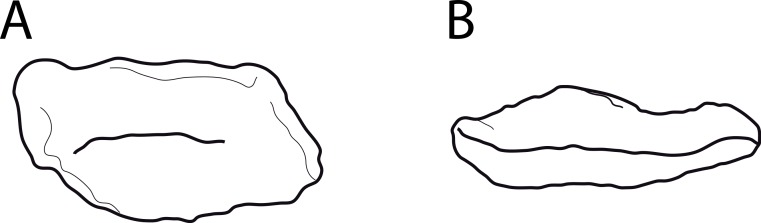
Diplodocid carpals.Carpal elements of Galeamopus sp. SMA 0011 (A) and Brontosaurus parvus UW 15556 (B; traced from Bonnan, 2003) in anterior view, illustrating the two different shapes described in C396: (0) block-like (A), and (1) disc-like (B). Scaled to the same transverse width.